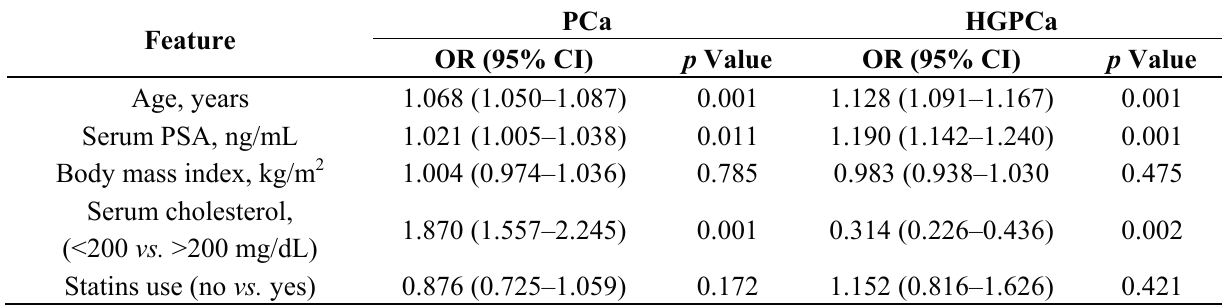
Table 3. Binary logistic regression of predictors of prostate cancer and high-grade prostate